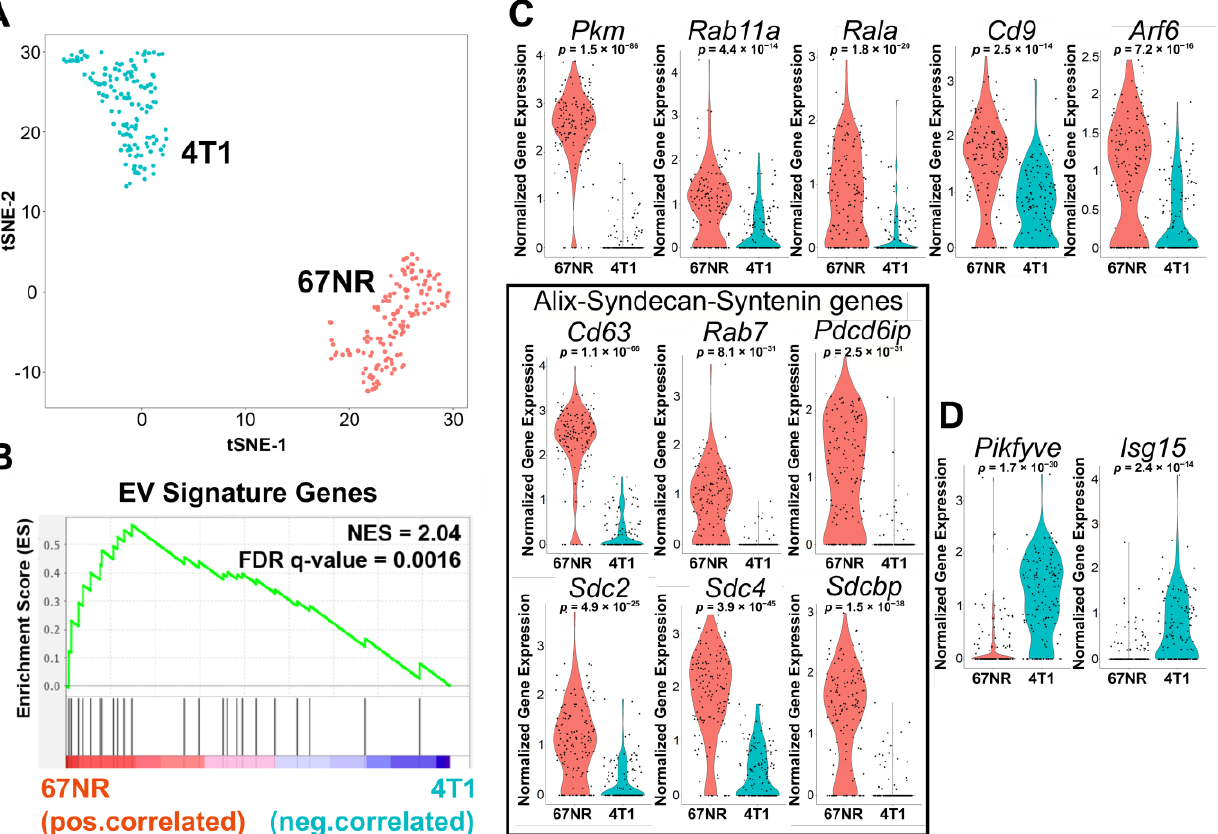
Figure 2. Comparison of 4T1 and 67NR cells by scRNA-seq. ( A ) t-SNE plot of 67NR (non-metastatic) and 4T1 (metastatic) breast cancer cells clusters analyzed by scRNA-seq. ( B ) Gene set enrichment analysis (GSEA) of the core EV gene signature studies within 67NR cells compared with 4T1 cells. The core gene signature was based on a previously described set of genes known to be involved in EV secretion (Table S1). ( C ) Violin plots of the EV secretion genes upregulated in 67NR in comparison with 4T1. Each dot represents one single cell. The black box highlights genes associated with the ALIX- Syndecan-Syntenin pathway. ( D ) Violin plots of EVs inhibitors, Pikfye , and Isg15 , upregulated in 4T1 cells in comparison with 67NR cells. Each dot represents one single